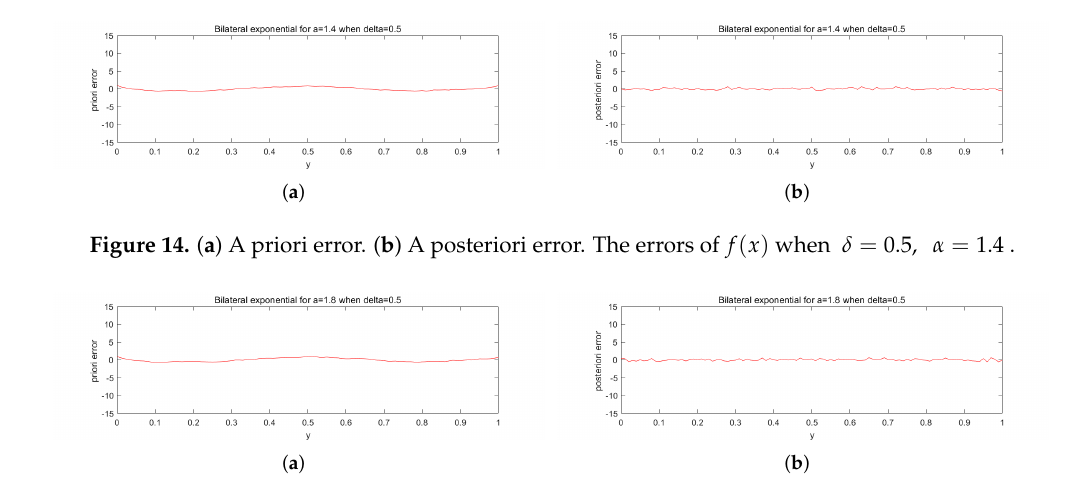
Figure 15. ( a ) A priori error. ( b ) A posteriori error. The errors of f ( x ) when δ = 0.5, α = 1.8.